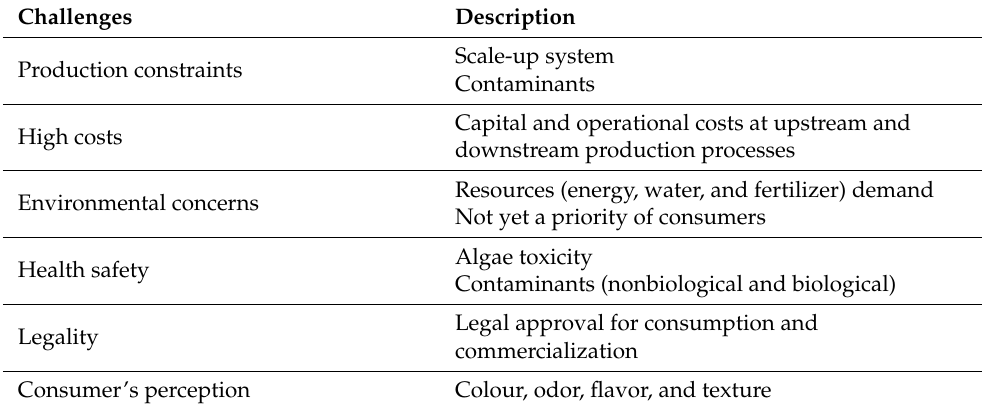
Table 1. Challenges to the consumption of algae as